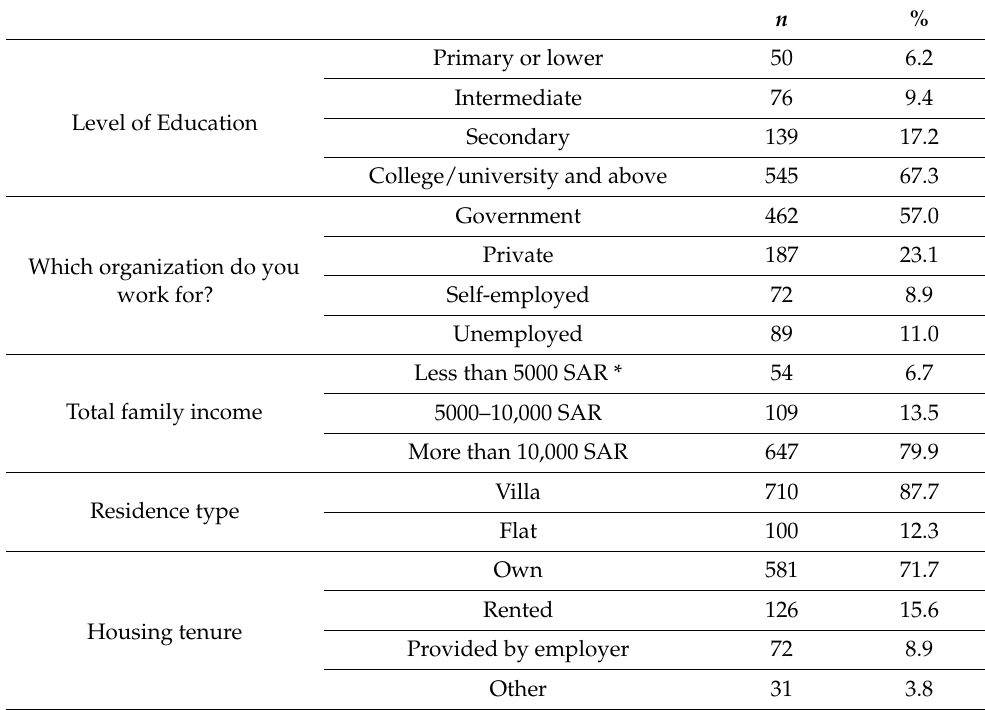
Table 1. Socioeconomic features.